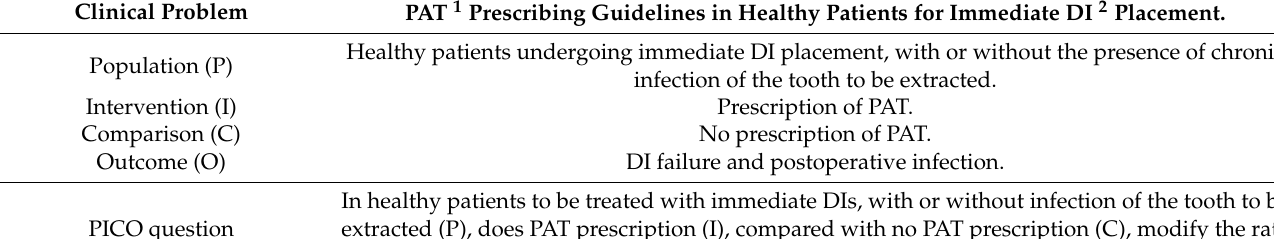
Clinical Problem